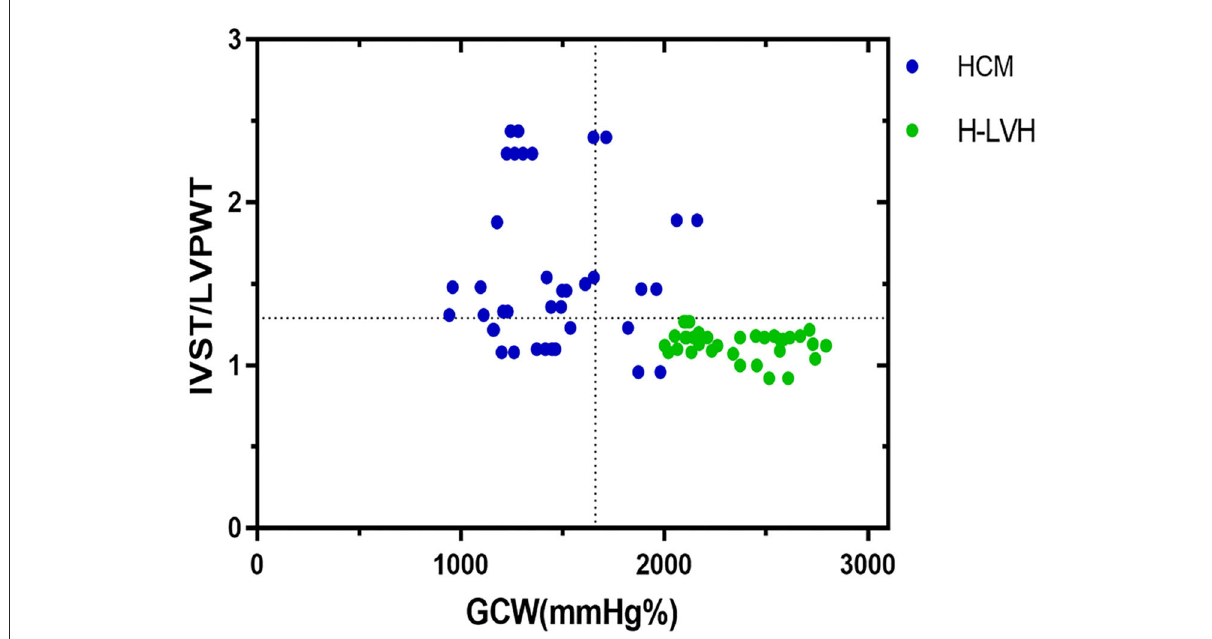
FIGURE3 Relation between IVST/LVPWT ratio and GCW in patients with HCM and H-LVH. Optimal cutoff values for discrimination between the two groups of patients are indicated (dotted lines).